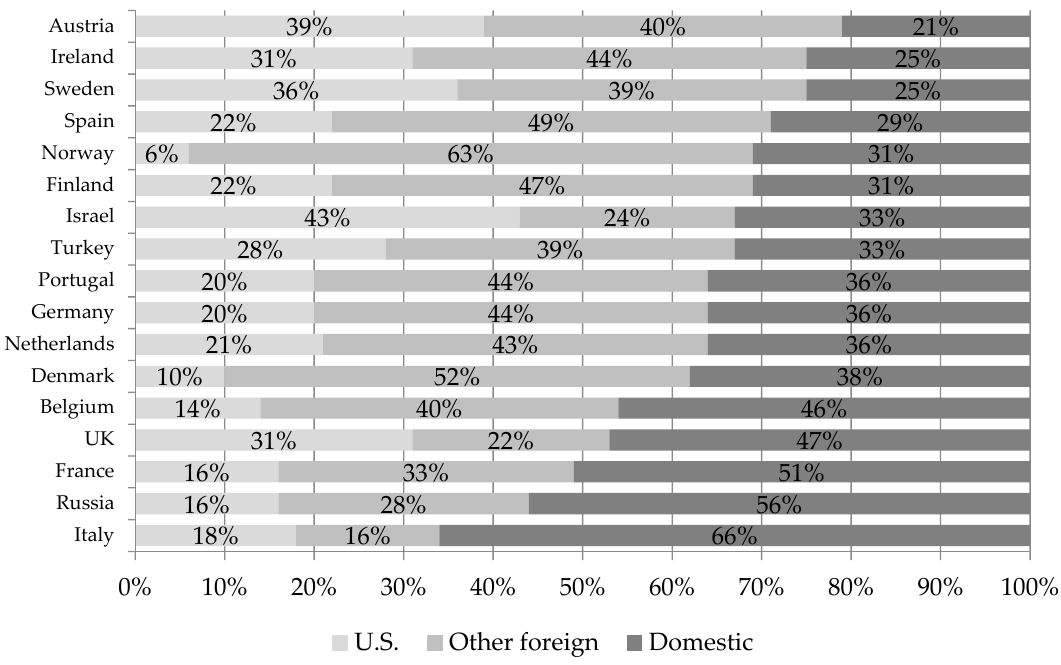
Figure 2. Country origins of investment amounts across European countries (2016) (Dealroom.co 2017). The figure assumes rounds with multiple investors are equally allocated and is based on investor HQ location. Other foreign refers mostly to other European.